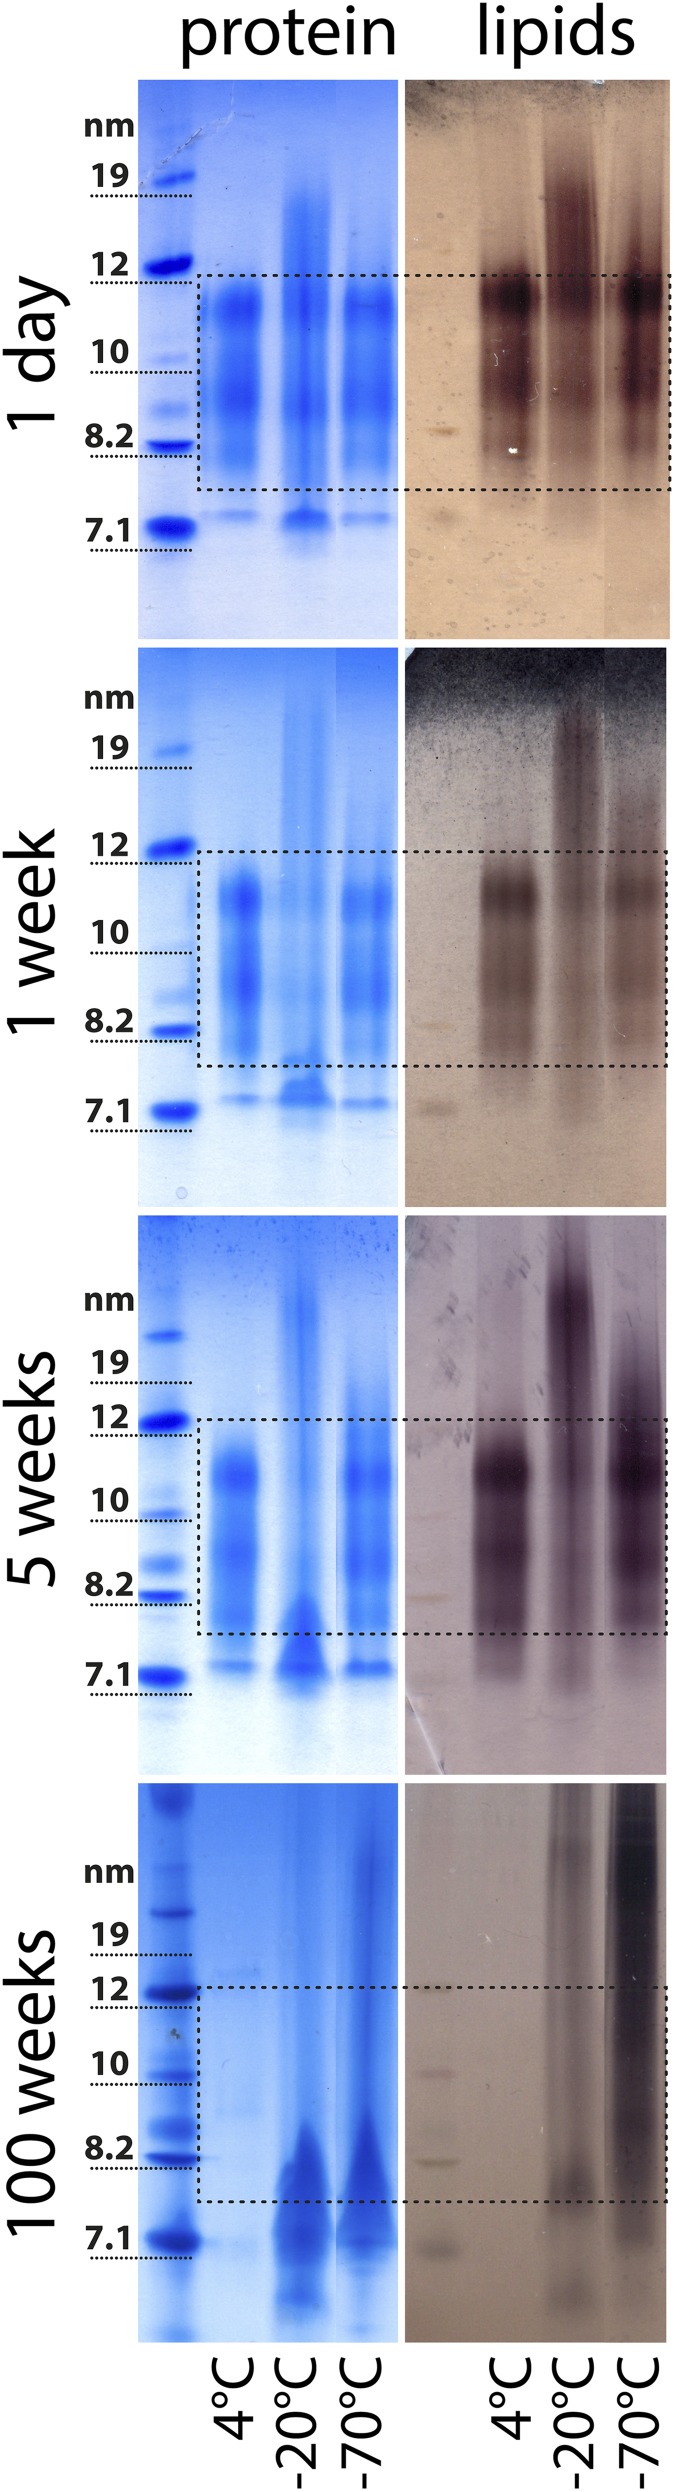
Native gel electrophoresis of isolated HDL after short- and long-term storage. HDL was isolated from serum from four healthy donors by density gradient ultracentrifugation and kept at 4, −20, or −70°C for up to 100 weeks. Aliquots were analyzed by native gel electrophoresis at different time points and stained with Coomassie brilliant blue for protein (left panel) or with Sudan black B for lipids (right panel). The dashed lines indicate the typical size range of HDL2 and HDL3 ranging from about 8 to 12 nm. HDL samples shown were from one gel, but were not directly adjacent to each other and, therefore, have been cut and assembled for illustration. Each storage experiment was repeated three times and results from one representative experiment are shown.